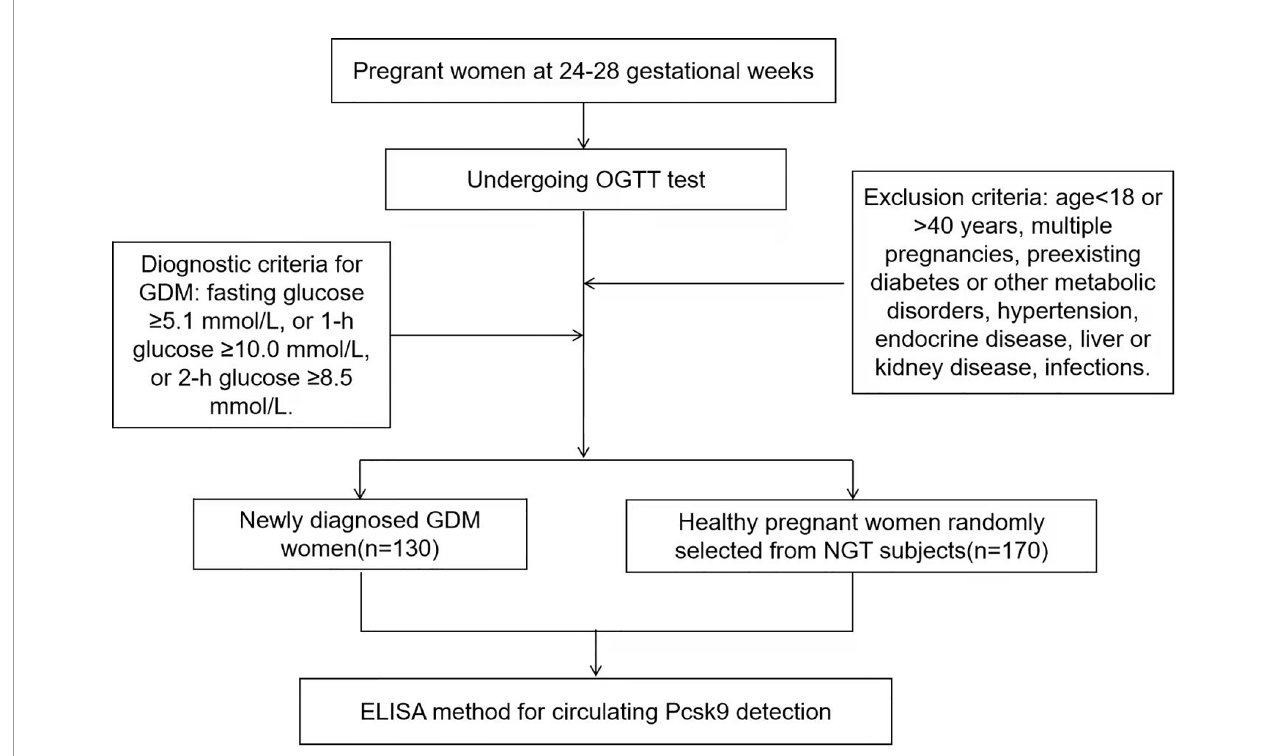
FIGURE 1 | Flow graph of study